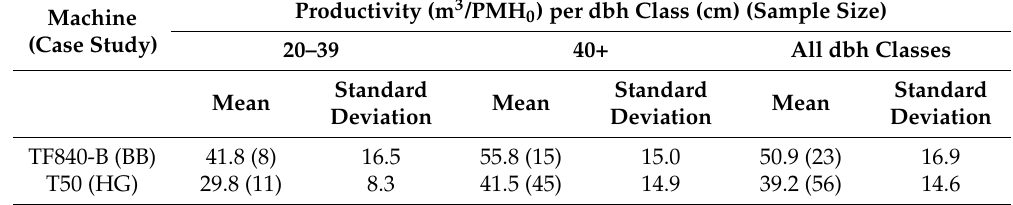
Table 8. Mean productivity and standard deviations per dbh class for the two machines (case studies) in the motor-manual (MM) group.